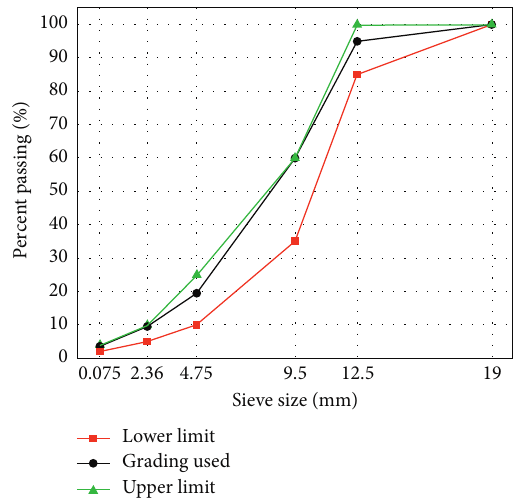
Figure 1: Results of the gradation composition of PAC (OGFC- 13).